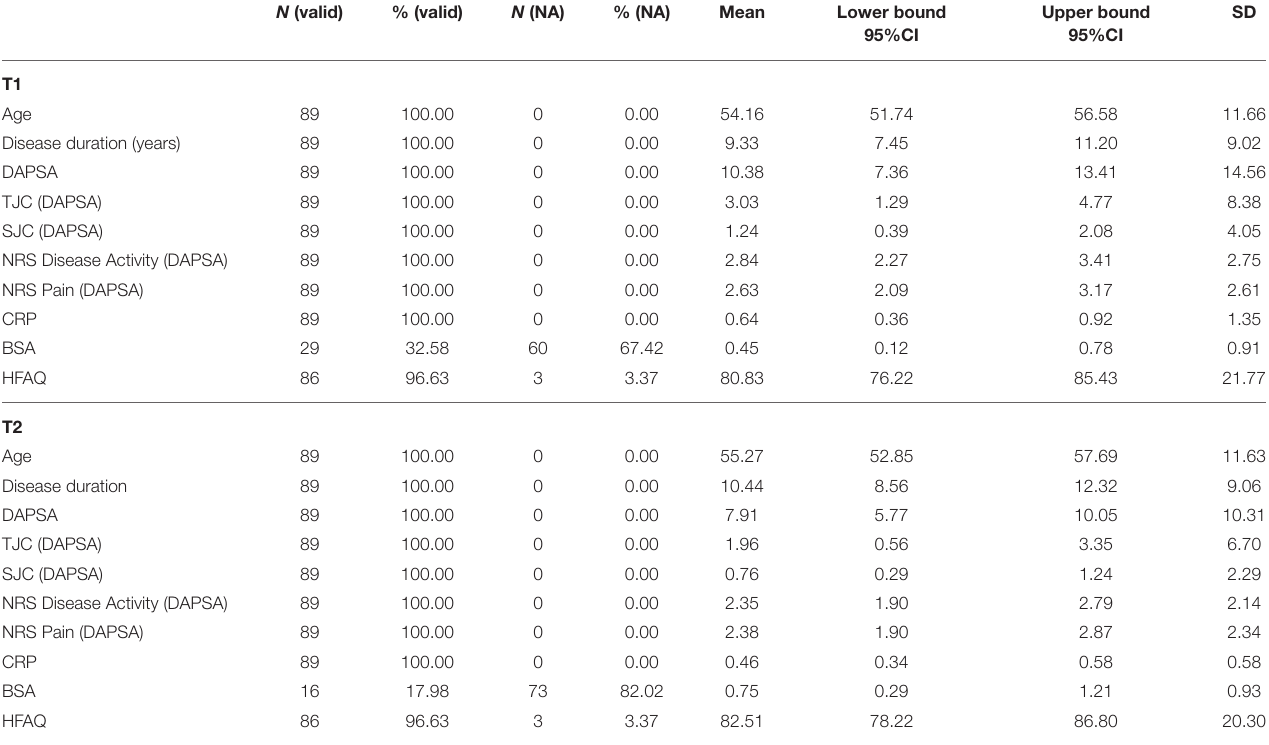
TABLE 1 | Descriptive sample characteristics before and during the SARS-CoV-2 pandemic.